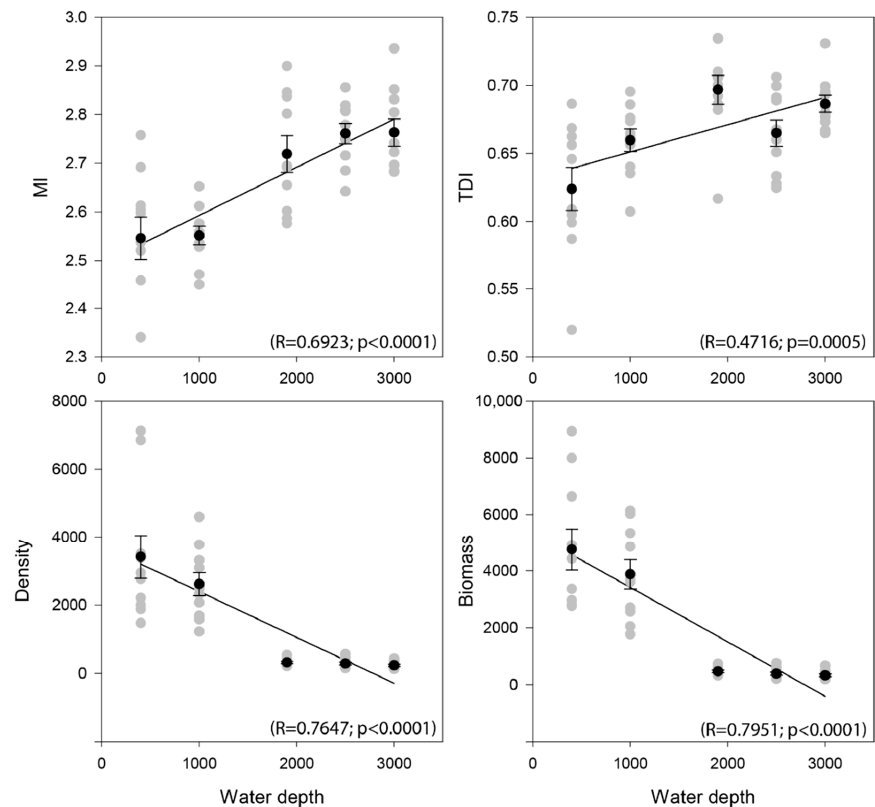
Figure 3. Linear regressions for functional nematode parameters along the bathymetric gradient. MI: maturity Index; TDI: trophic diversity index. Density is expressed in ind./10 cm 2 ; biomass is expressed in µg wet weight/10 cm 2 . Error bars denote standard errors.